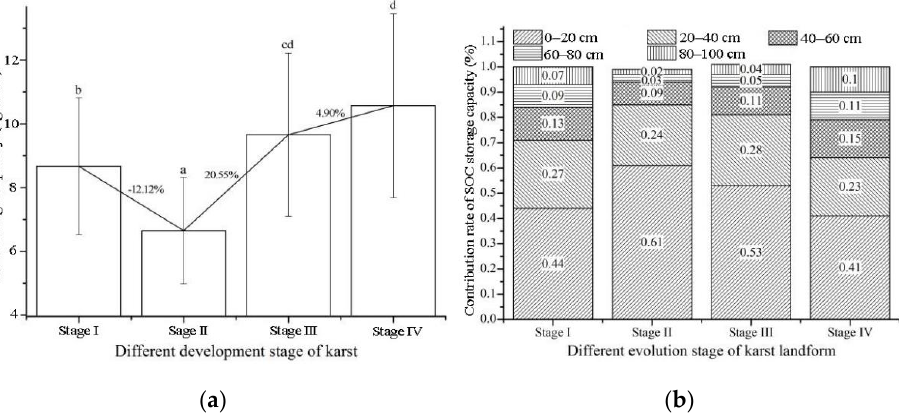
Figure 7. Information on SOC storage capacity. Panel ( a ) shows the change in SOC storage capacity in different karst stages; ( b ) shows the contribution rate of SOC storage capacity in different soil layers of different karst